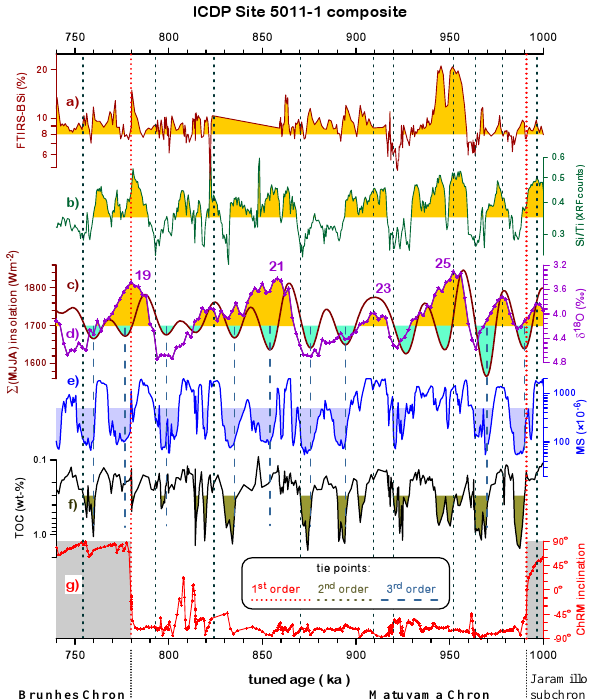
Fig. 4. Definition of 1st, 2nd, and 3rd order tie points of the age model: Chronostratigraphic plot for the time window 740ka to 1000ka of (a) biogenic silica (FTIRS-BSi), (b) Si/Ti ratio, with high (low) ratios indicating higher (lower) biogenic input with re- spect to lithogenic input, (c) cumulative summer (May to August) insolation for 67.5 ◦ N (according to Laskar et al., 2004), (d) LR04 oxygen isotope stack ( δ 18 O) from Lisiecki and Raymo (2005), (e) magnetic susceptibility (MS), (f) total organic carbon (TOC), and (g) ChRM inclination, with grey (white) indicating normal (re- versed) polarity. Geomagnetic field reversals are defined as 1st order tie points of the age model. Correlation of Si/Ti ratio and biogenic silica to the LR04 stack define 2nd order tie points, and correlation of magnetic susceptibility and TOC to insolation patterns define 3rd order tie points. For further details, see text. FTIRS – Fourier trans- form infrared spectroscopy, XRF – X-ray fluorescence, ChRM – characteristic remanent magnetization.